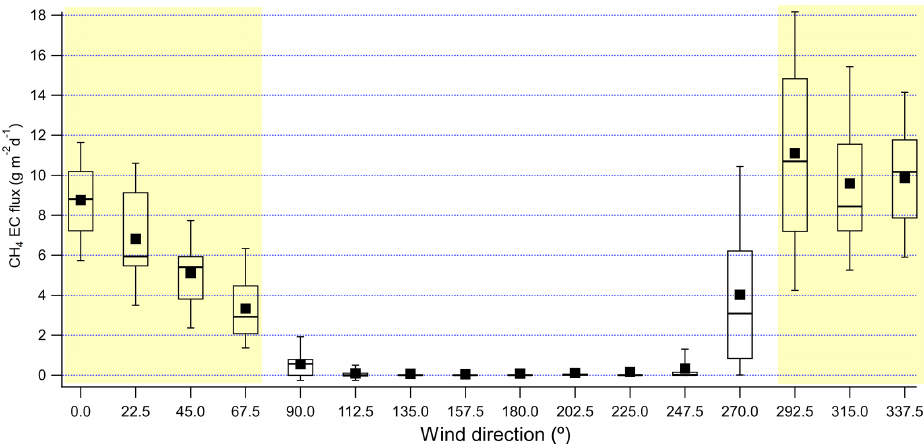
Figure 7. EC flux of CH 4 as a function of wind direction binned in 22.5 ◦ bins. Lower and upper bounds of the box plot are the 25th and 75th percentile; the line in the box marks the median and the black square labels the mean; the whiskers label the 10th and 90th percentile. Yellow shades indicate the wind directions from the